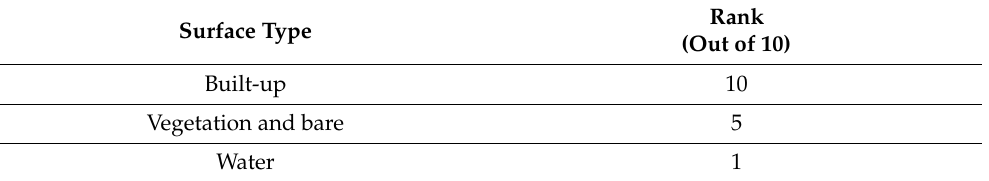
Table 7. Ranking of sub-class parameters—ISF.